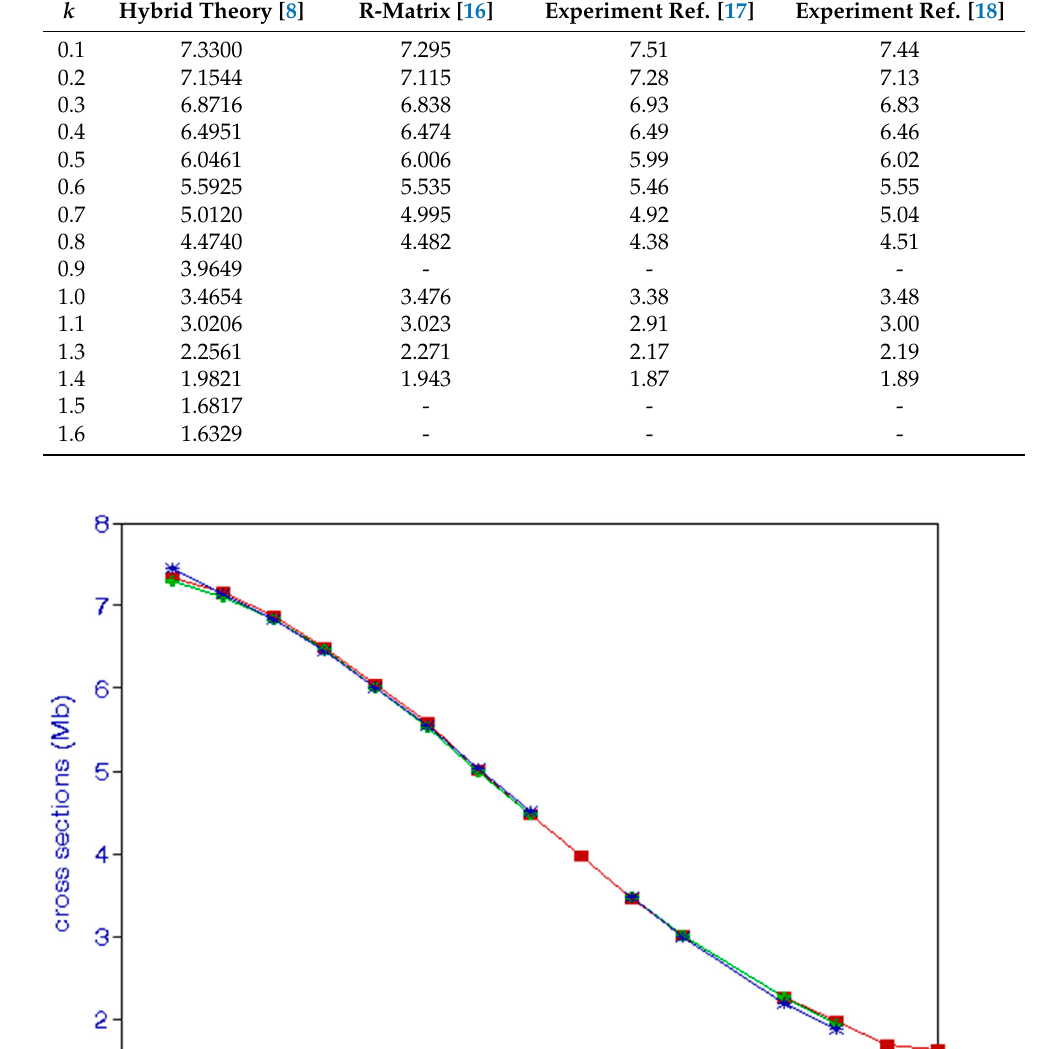
Table 2. Photoionization cross sections (Mb) for the ground state of He obtained with correlations. k